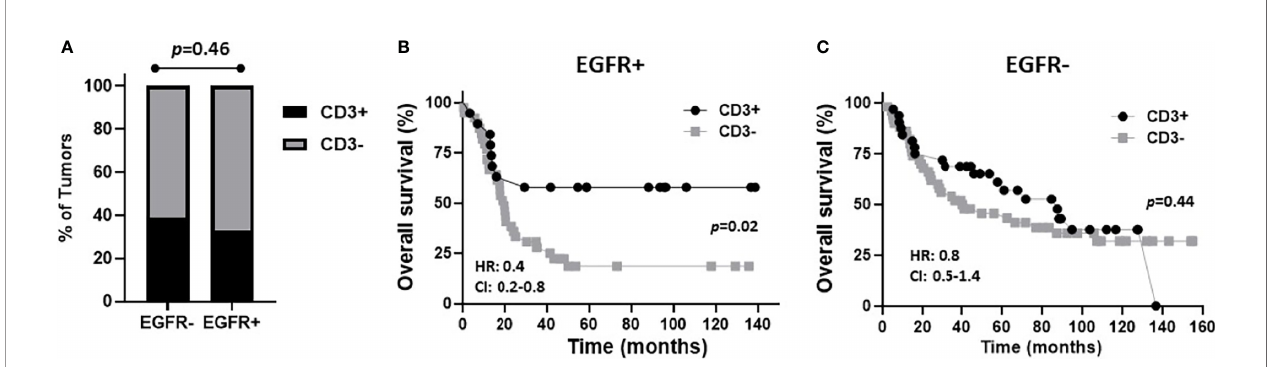
FIGURE 5 | Prognostic impact of combined EGFR and CD3 expression in OSCCs. (A) : Shown are percentages of tumors with CD3+ and CD3- expression based on EGFR status. (B, C) : Shown are Kaplan-Meier estimates of overall survival of CD3+ and CD3- patients based on EGFR+ (B) or EGFR- (C) tumor expression. HR, hazard ratio; CI: 95% con fi dence